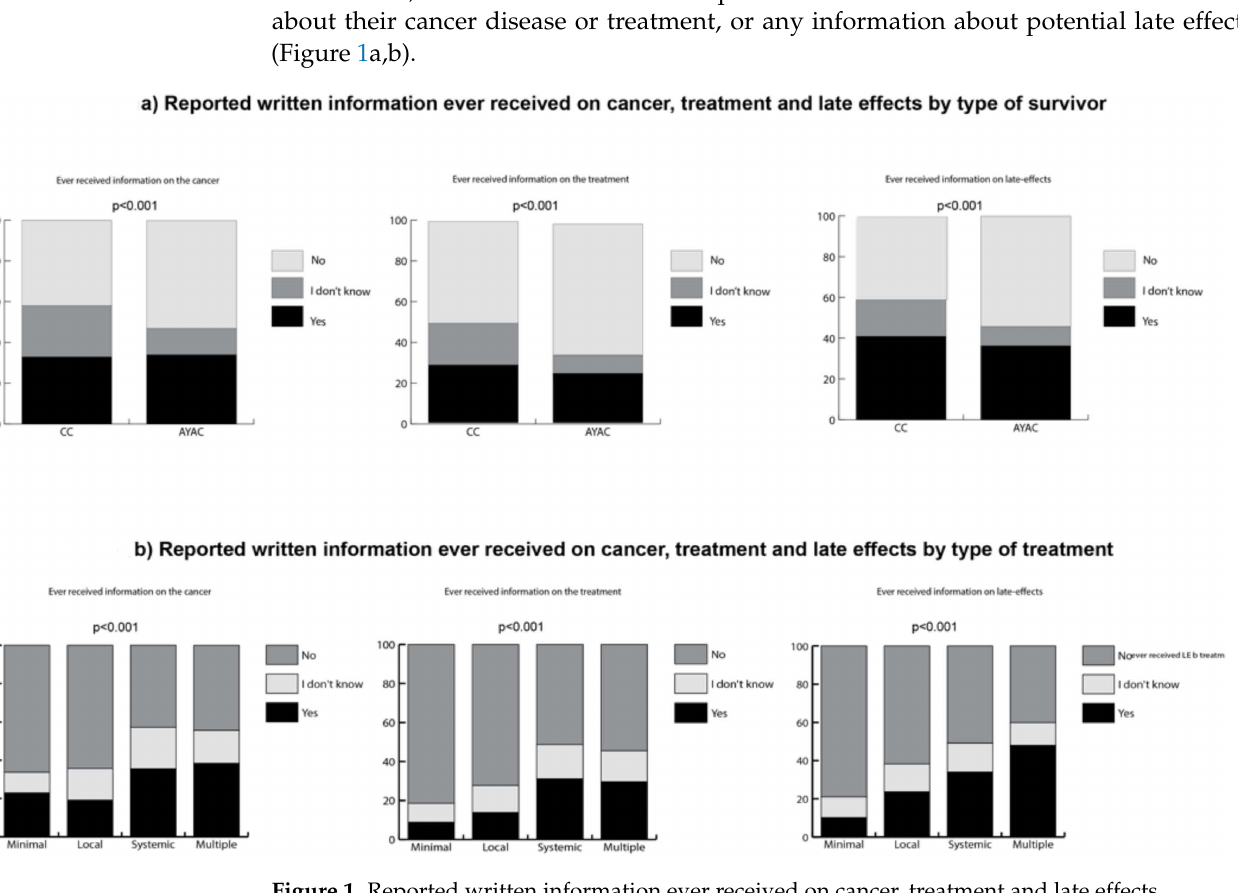
Figure 1. Reported written information ever received on cancer, treatment and late